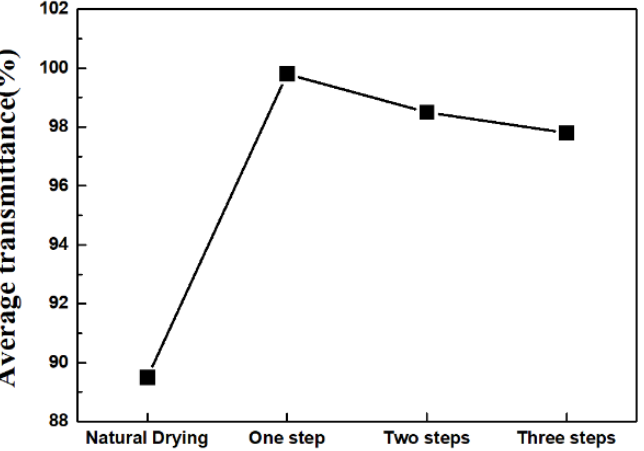
Figure 4. Average light transmittance of the substrates coated and annealed once, twice, and thrice. The adhesion property of the films was tested using the ASTM D3359 procedure. The test was performed by making squares and counting the number of detaching squares.